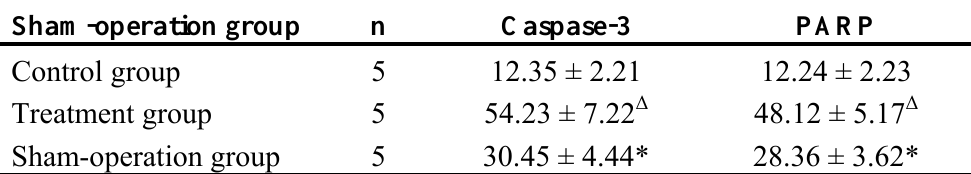
Table 5. The concentration in brain tissue of caspase-3 and PARP ( x ±